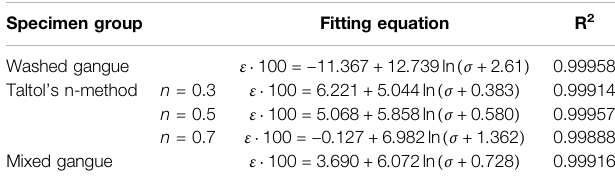
TABLE 10 | Stress – strain curve